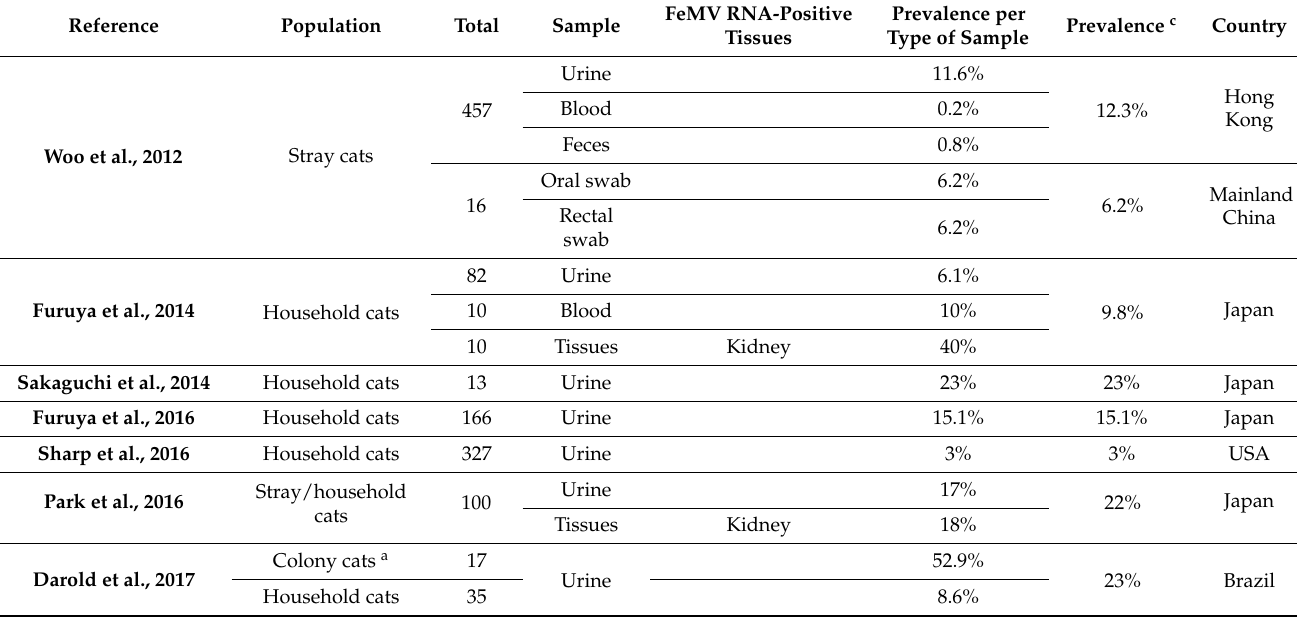
Table 1. Reported FeMV molecular prevalence of cats in relation to population sampled, type of sample, and geography.